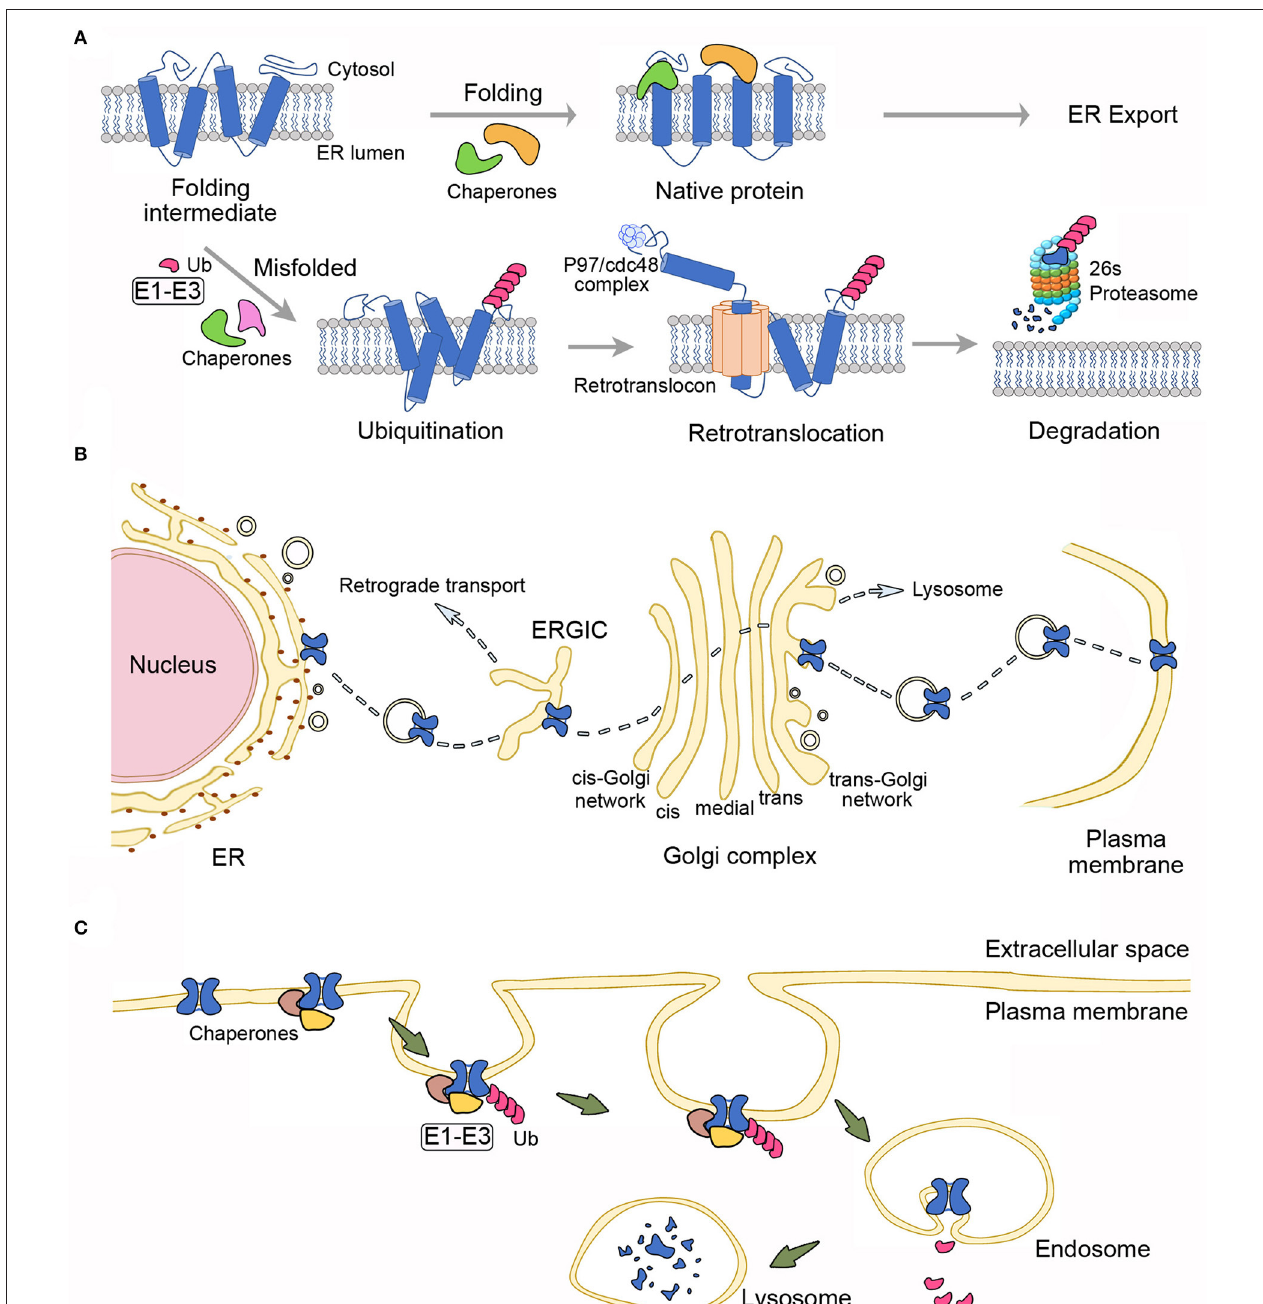
FIGURE 2 | Proteostasis mechanisms governing the surface expression of membrane proteins. (A) Endoplasmic reticulum (ER) quality control. Protein folding at the ER is assisted by multiple molecular chaperones and cochaperones. Proteins with native folding conformation may pass the ER quality control system and are allowed to exit the ER. Chaperones/cochaperones also recognize misfolded proteins, which are subject to covalent linkage with ubiquitin (Ub) via the concerted action of three types of ubiquitination enzymes (E1–E3). The ER-associated degradation system will further target ubiquitinated proteins for retrotranslocation into the cytoplasm through the channel-like, ER membrane-localized retrotranslocon, as well as with the facilitation by the ATPase p97/Cdc48 complex. Retrotranslocated proteins are then destined for degradation by the 26S proteasome. (B) Membrane trafficking. Immature, native membrane proteins from the ER are packaged into transport vesicles and transferred through the ER-Golgi intermediate compartment (ERGIC) and the Golgi complex, wherein they go through further post-translational modifications. Mature proteins are eventually ushered to the plasma membrane. Misfolded proteins that escape the ER quality control system and reach the Golgi complex may still be recognized by the Golgi quality control system, followed by retrograde transport back to the ER, or antegrade transport to the lysosome. (C) Peripheral quality control. Molecular chaperones/cochaperones at the plasma membrane may recognize membrane proteins with conformational defects and recruit enzymes (E1–E3) for ubiquitination of the misfolded proteins, which in turn are targeted for endocytosis and lysosomal degradation.